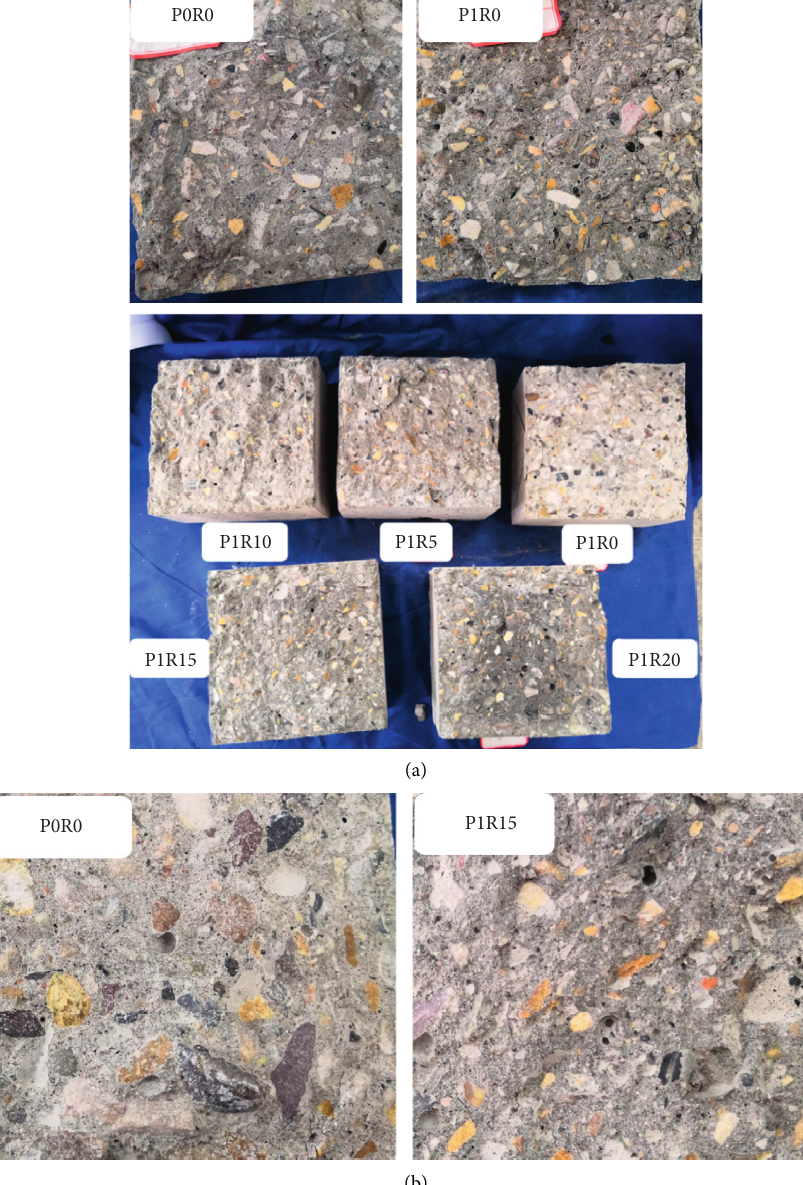
Figure 7: The fracture surface in